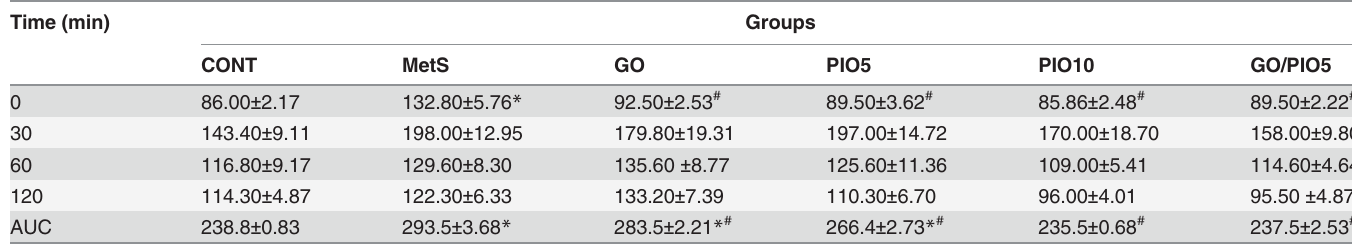
The fasting blood glucose titer (mg/dl) at different time intervals (0, 30, 60, and 120 min) after intraperitoneal glucose (2 g/kg) administration is presented as mean (6 – 8 animals) ± SEM, while the calculated area under the curve (AUC) of glucose is presented. P < 0.05, as compared to control (CONT) ( * ) and MetS ( # ) groups using one-way ANOVA followed by Tukey – Kramer